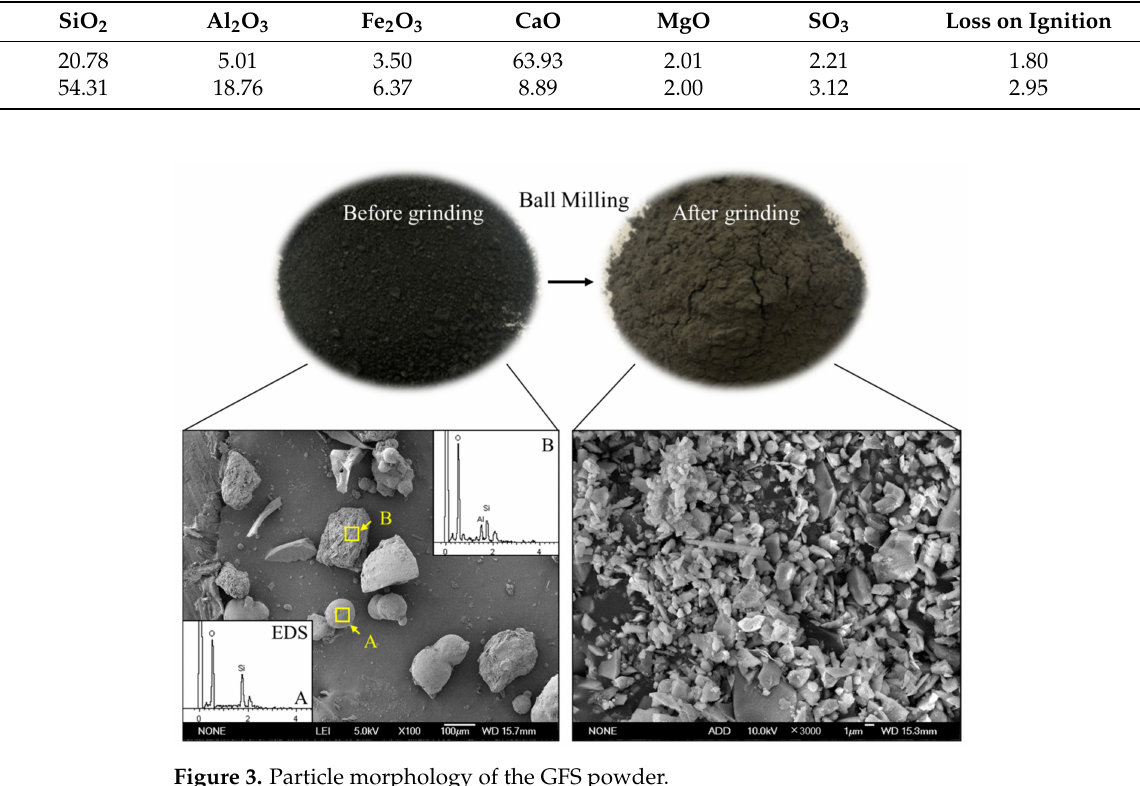
Table 1. Chemical compositions (/%) of cement and GFS.